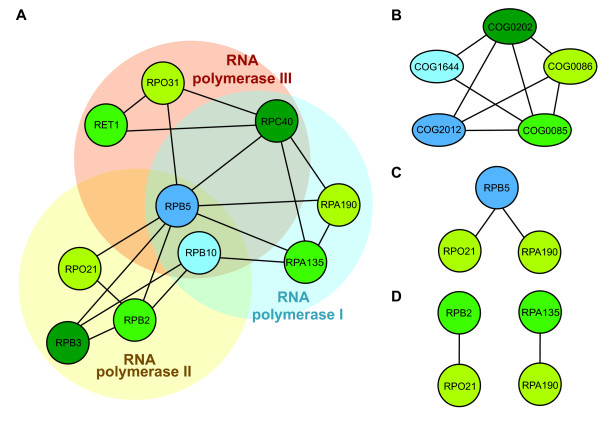
Example of network collapse into protein families. We show here part of the Literature Curated S. cerevisiae protein interaction network, involving interactions between certain components of RNA polymerases. A. The sub network in its original state. Nodes are colored according to their age (green: ABE, blue: AE/BE), individual families are in different shades of the same color. B. The subnetwork collapsed into protein families. C. Duplication in a single family: two edges that share a node (RBP5). D. Duplications in both families: non-overlapping edges (RPB2-RPO21, RPA135-RPA190, RET1-RPO31).